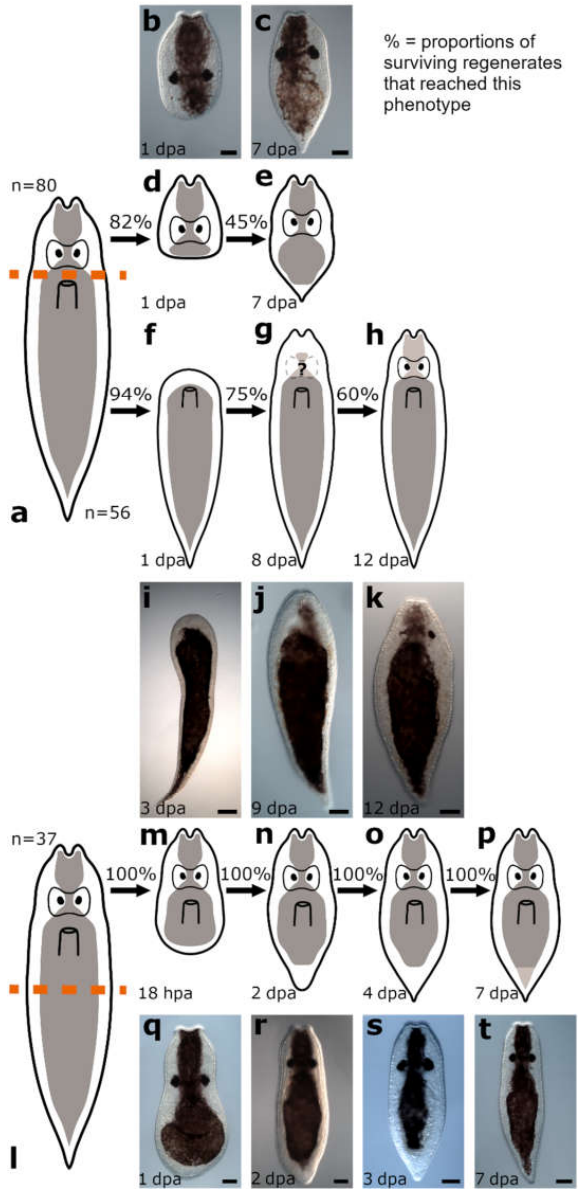
Figure 7. Regeneration in Vorticeros auriculatum . Amputation between brain and pharynx ( a ). Posterior regenerates fully healed the wound ( b , d ). A small tail was regenerated ( c , e ), but no pharynx primordium was clearly visible. Anterior regenerates fully healed the wound and started to form a blastema-like structure ( f , i ). The original head shape, including the peculiar anterior-facing tentacles, was restored ( g , j ). Eyes and pigmentation were regenerated in anterior regenerates ( h , k ). Amputation posterior to the pharynx ( l ). A small blastema-like structure became visible ( m , q ), a somewhat roundish tail started to form ( n , r ), developed over time into the original tail shape ( o , s ). Pigmentation in the new tail tip was restored ( p , t ). Scale bars: 50 µ m in ( b , c , j , k ) and ( q – t ); 100 µ m in ( i